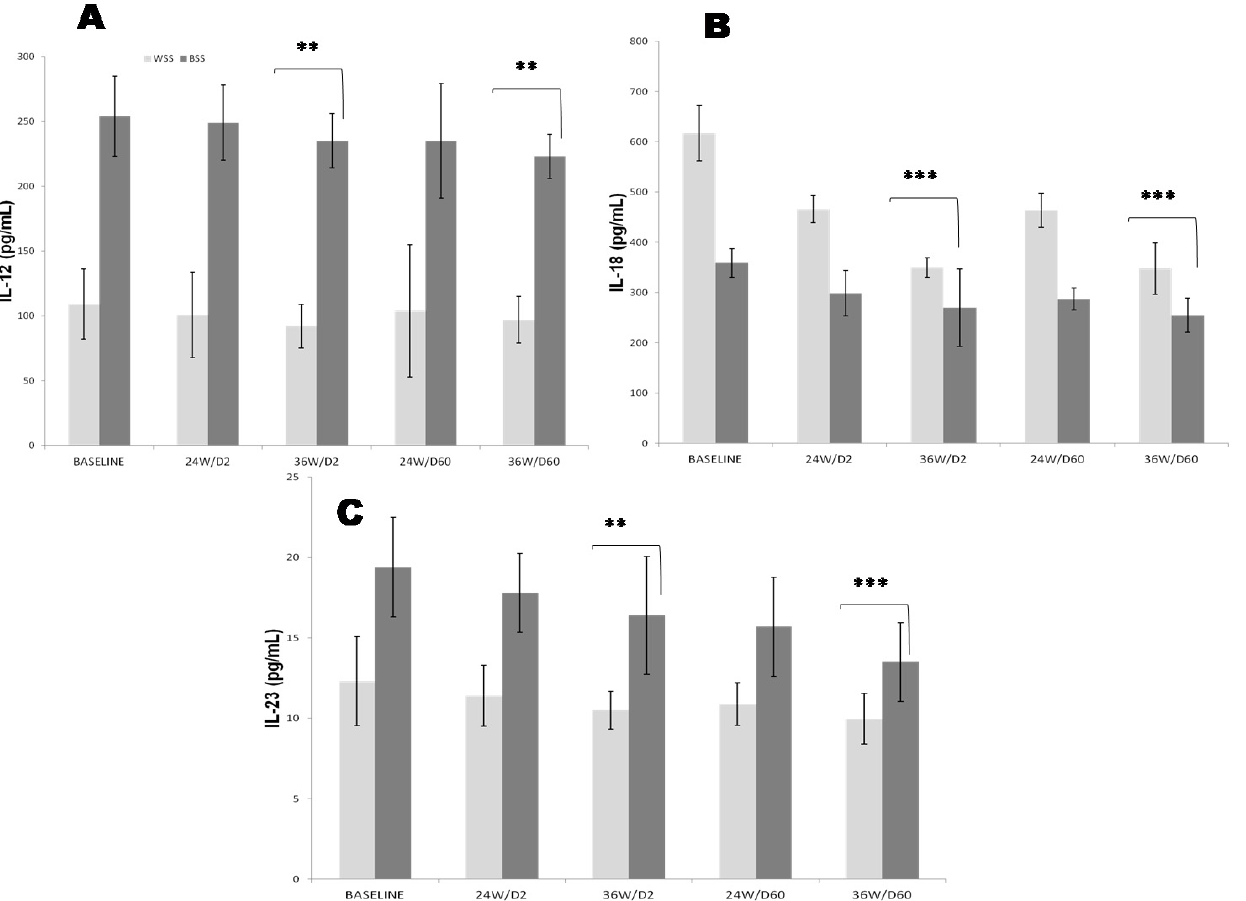
Figure 3. Effects of oral 2000 IU/day and 60,000 IU/month vitamin D 3 supplementation on plasma ( A ): IL-12 (interleukin-12), ( B ): IL-18 (interleukin-18) and ( C ): IL-23 (interleukin-23) in CKD White and Black SS people at 2000 IU doses every day (D2 group) versus 60,000 IU doses every